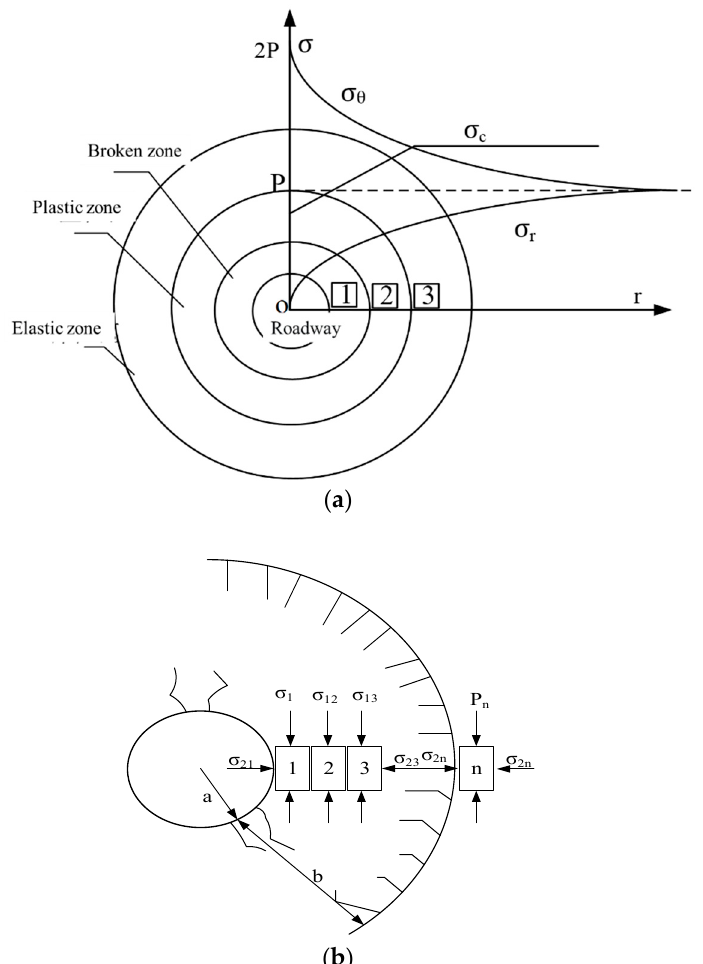
Figure 4. Mechanical model after roadway excavation; ( a ) Mechanical model of surrounding rock; ( b ) Stratified failure of surrounding rock physical state [26].